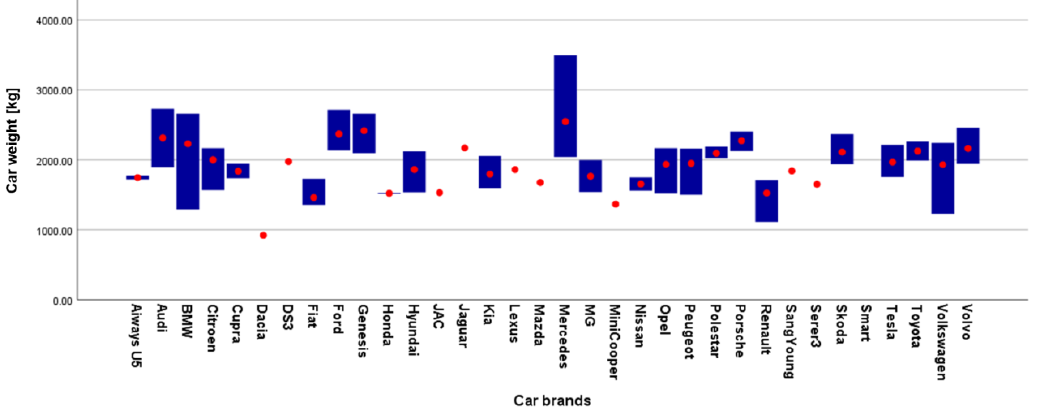
Figure 14. Range bar variation (min, max, mean) representation of vehicle weight vs. brands of cars.